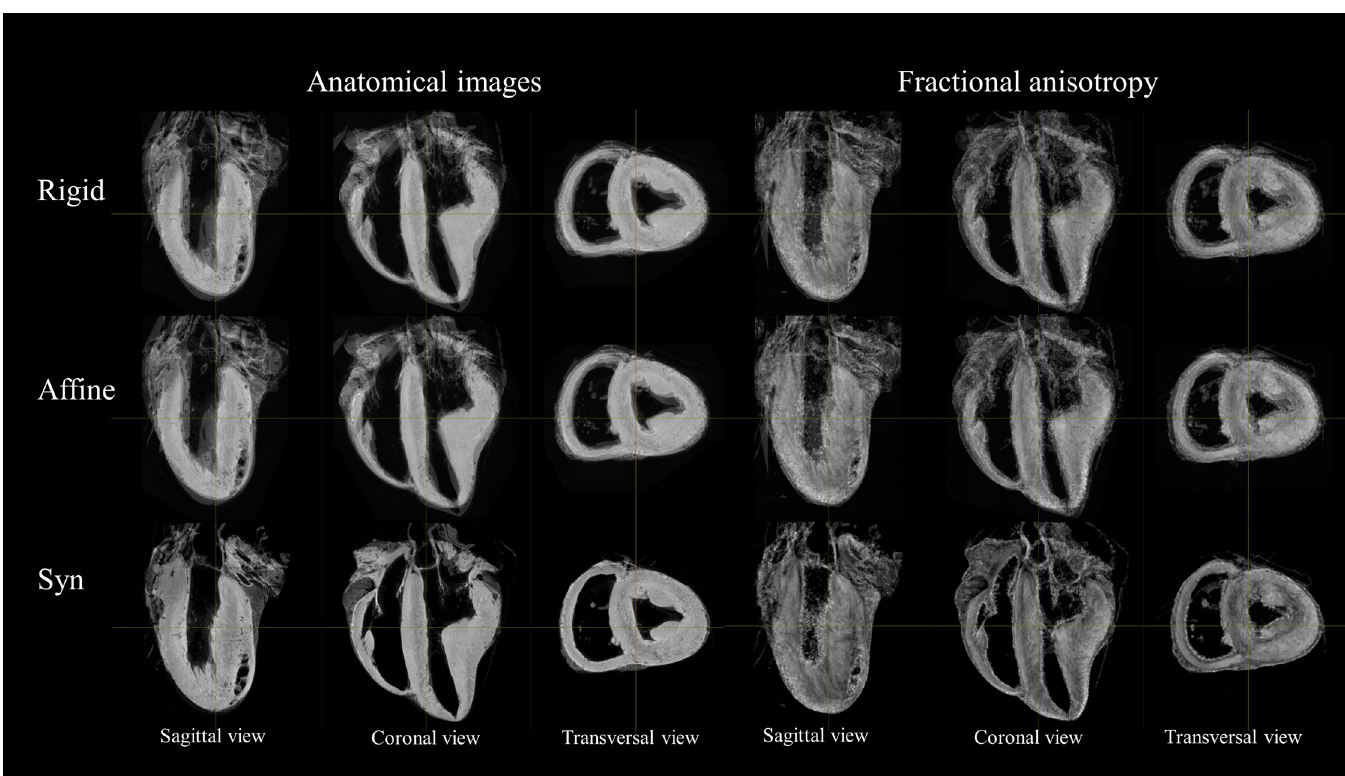
Fig 2. Impact of the transformation model during the registration on anatomical and FA template. Sagittal coronal and transverse view of anatomical (left) and FA (right) template using Rigid (top row), Affine (middle Row), SyN (bottom row). Mis-registration areas using Rigid or Affine transform are visible in the basal part of the sample, at the apex or on the papillary